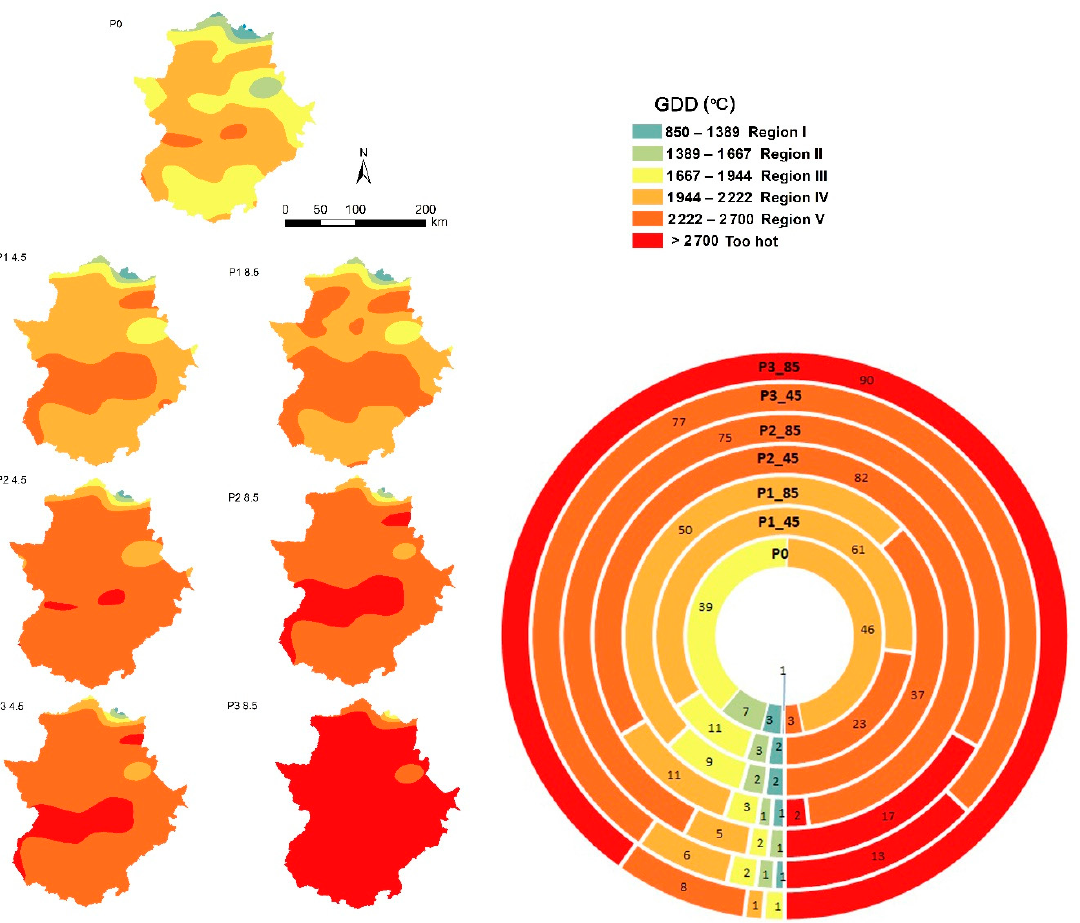
Figure 5. Spatial distributions of GDD during the historical period (P0) and the future time periods (P1, P2 and P3) in Extremadura. The percentages of each GDD class for all time periods and under both scenarios, RCP 4.5 and RCP 8.5, are also shown (for instance, P1.45 means the time period P1 under the scenario RCP 4.5).